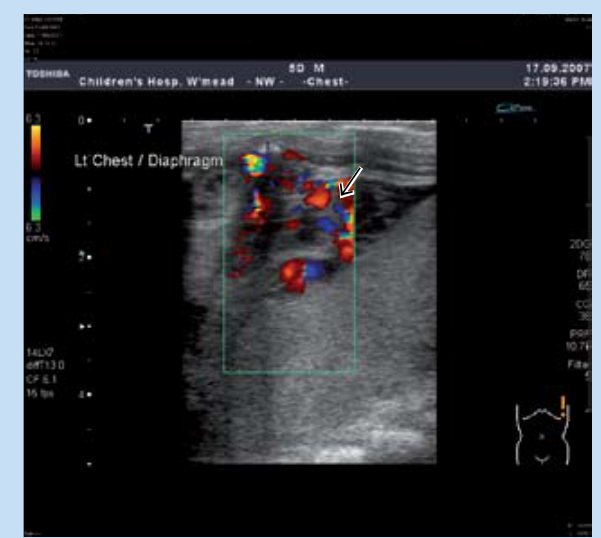
Fig. 1b. Colour Doppler ultrasound shows vascular malformation (arrow) displacing spleen inferiorly.